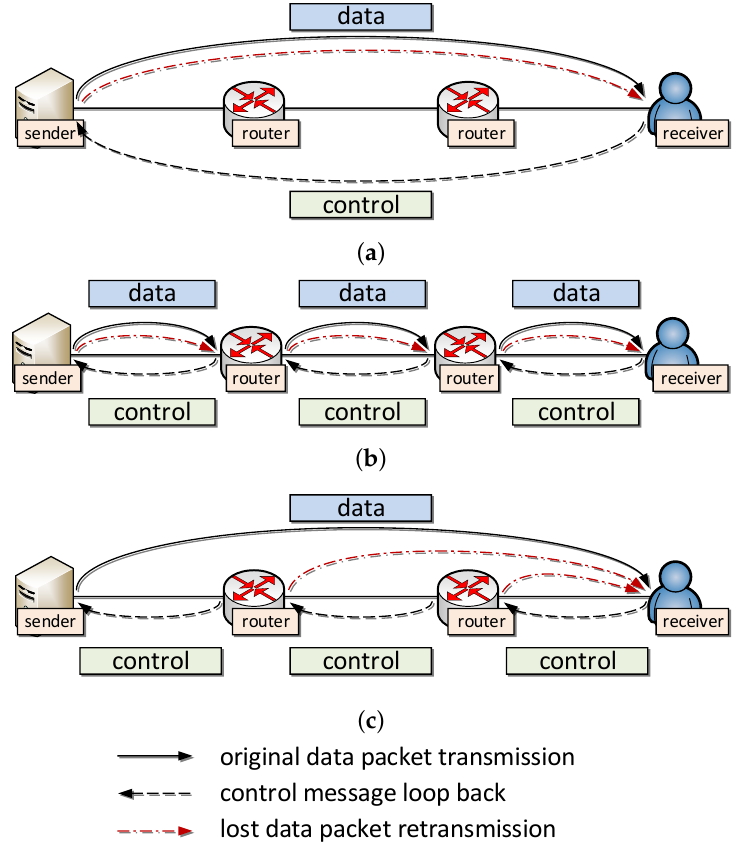
Figure 1. Control loop of three types of transport protocols. ( a ) End-to-end flow transport protocol (EF-TP), ( b ) hop-by-hop chunk transport protocol (HC-TP), and ( c ) hop-by-hop flow transport protocol